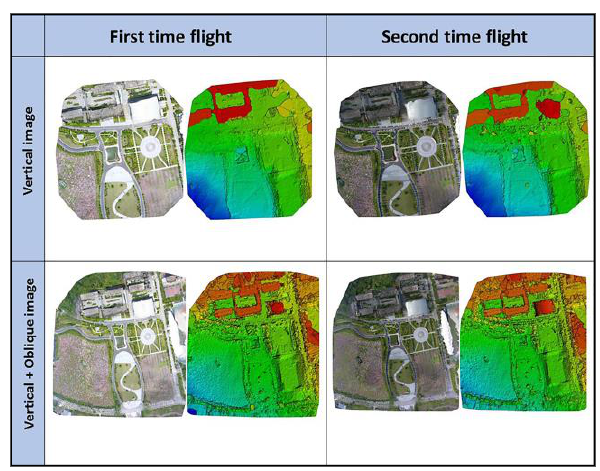
Figure 6. Ortho mapping and DSM data of first-second flights.